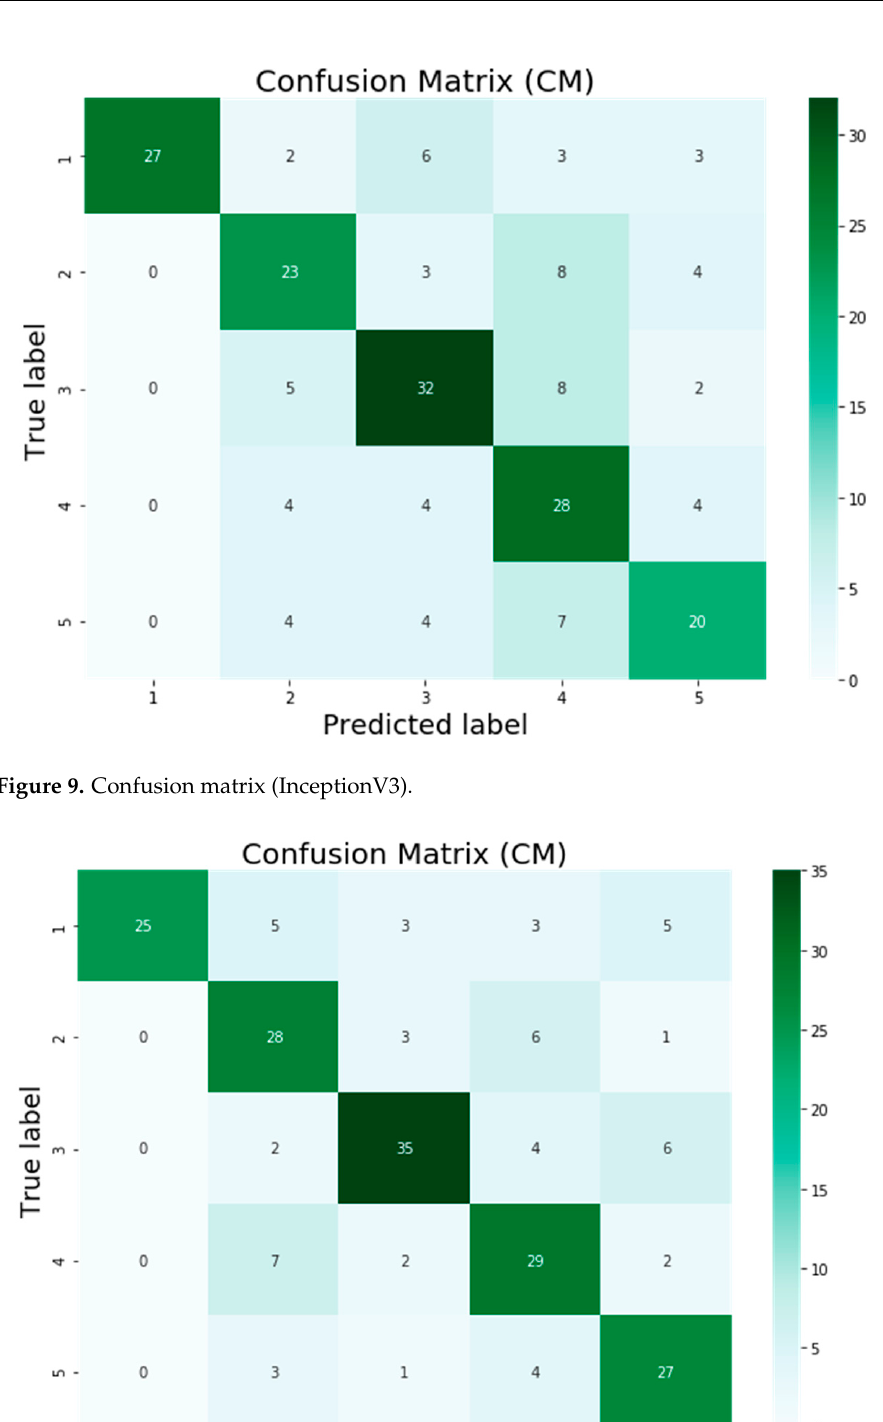
Figure 8. Confusion matrix (VGG16).